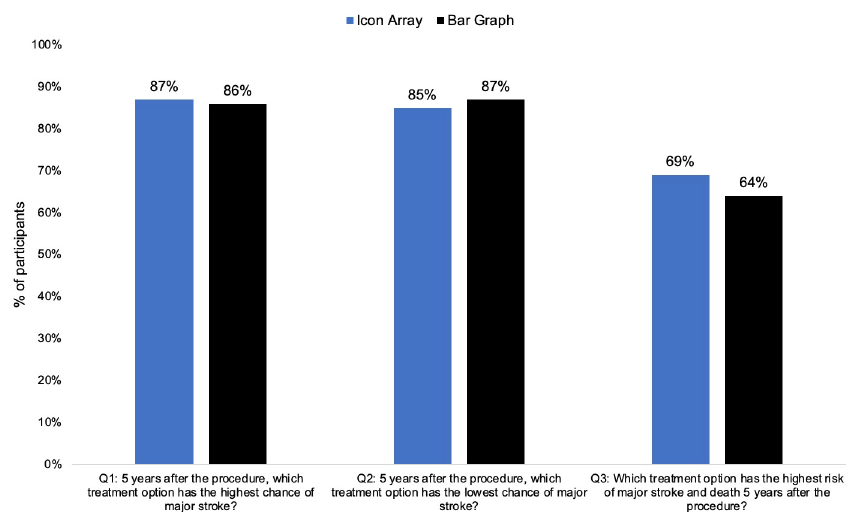
Fig 4. The percentage of participants in each trial arm that correctly answered each knowledge question in the survey.